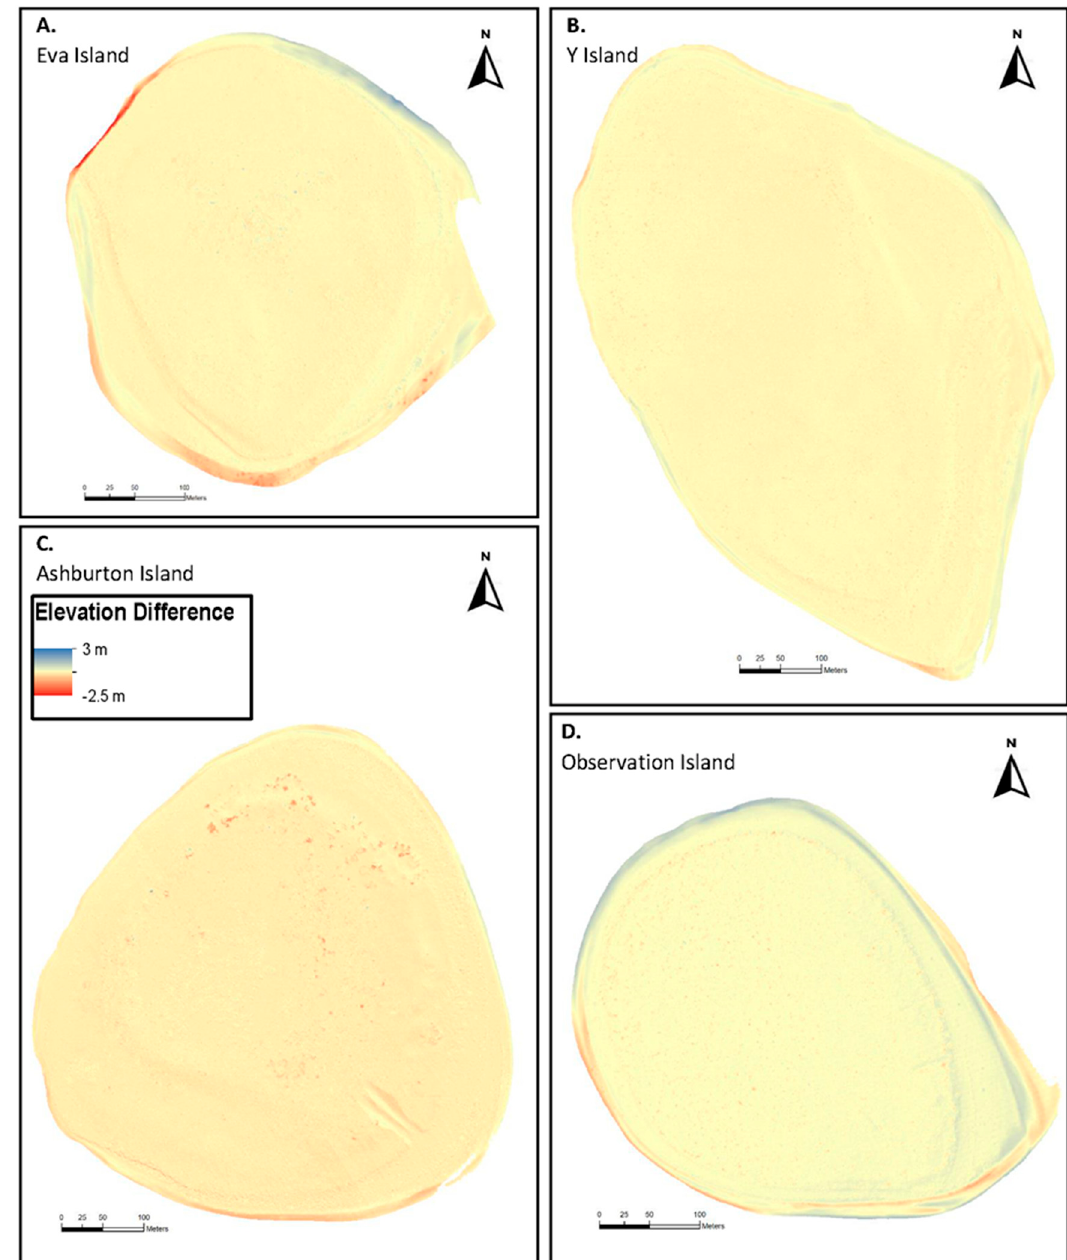
Figure 5. Surface difference between 2016 and 2018 illustrating elevation (m) gain (blue) and loss (red) for ( A ) Eva, ( B ) Y, ( C ) Ashburton, and ( D ) Observation islands.